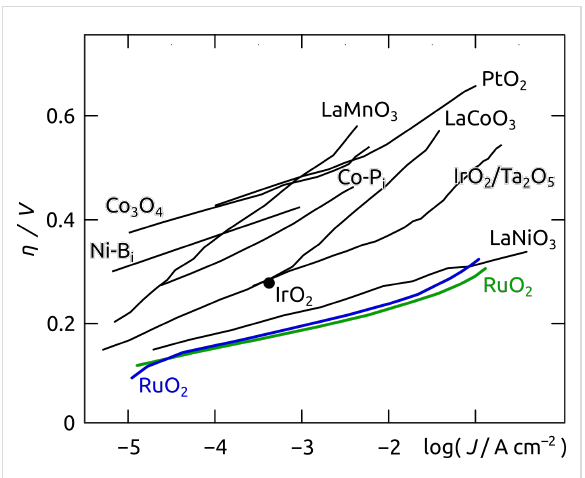
Figure 1: Selected oxygen evolution activities for planar state-of-the- art electrode materials (adapted from a review by Cook et al.) [9]. The overpotential η is shown here as a function of the logarithm of the cur- rent density J . The catalytic performance of ruthenium oxide in concen- trated acidic and basic conditions is highlighted in green and blue, re- spectively.